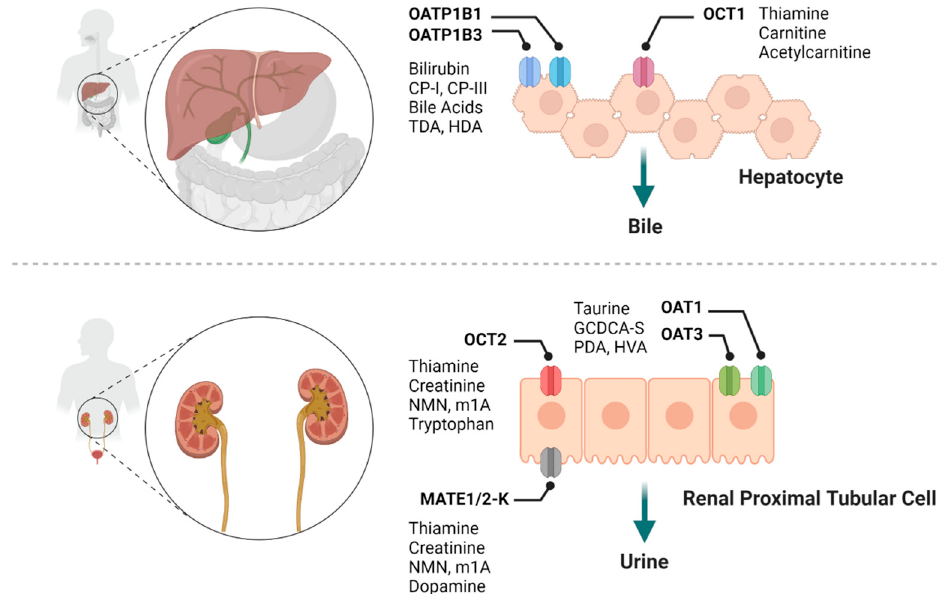
Figure 1. Summary of various drug transporters and their potential endogenous biomarkers. CP-I, coproporphyrin I; CP-III, coproporphyrin III; TDA, tetradecanedioate; HDA, hexadecanedioate; NMN, N 1 -Methylnicotinamide; m 1 A, N 1 -Methyladenosine; GCDCA-S, glycochenodeoxycholate-3- sulfate; PDA, pyridoxic acid; HVA, homovanillic acid.